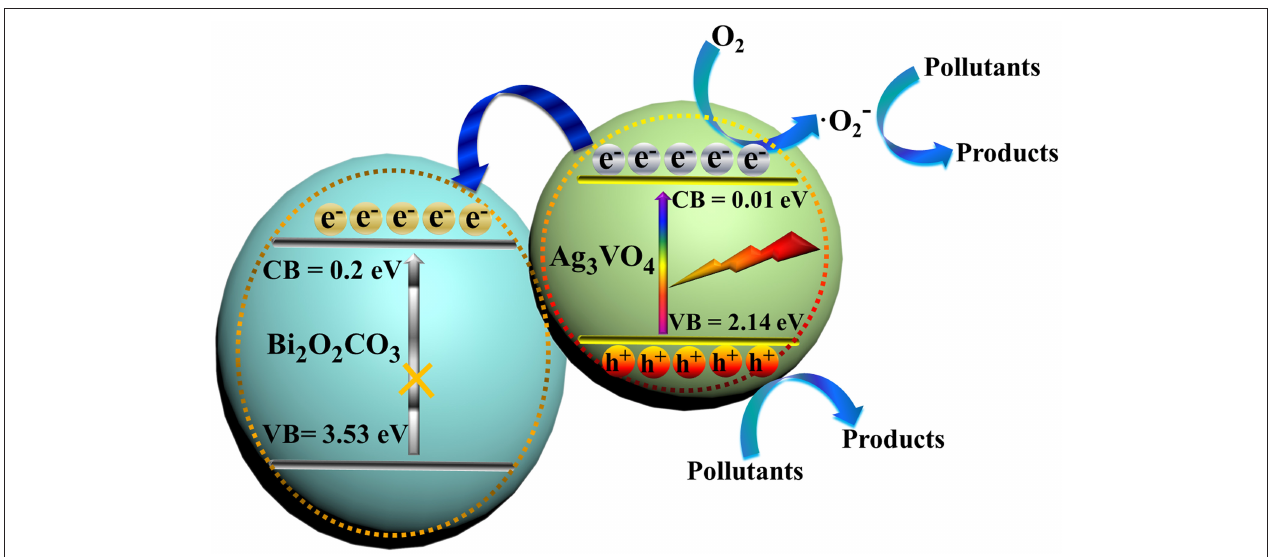
FIGURE 10 | Photocatalytic degradation mechanism of toxic pollutant over Ag 3 VO 4 /Bi 2 O 2 CO 3 .